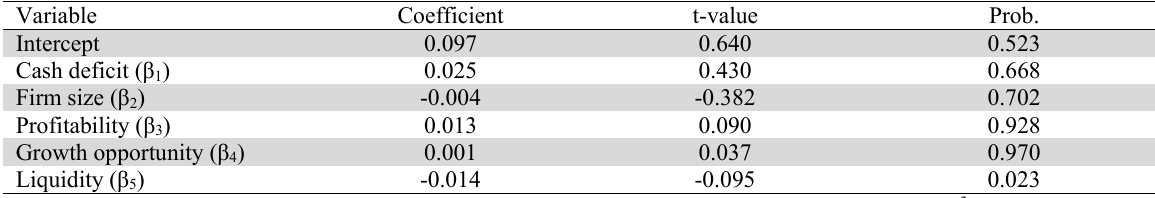
The summary of testing the first hypothesis